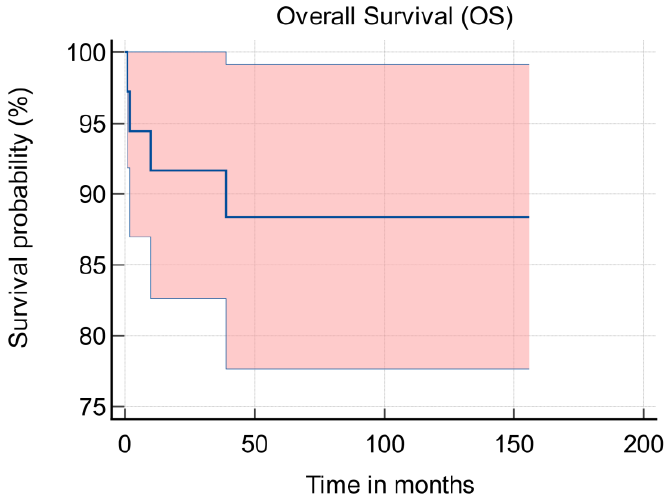
Figure 3. Kaplan-Meier survival graph.